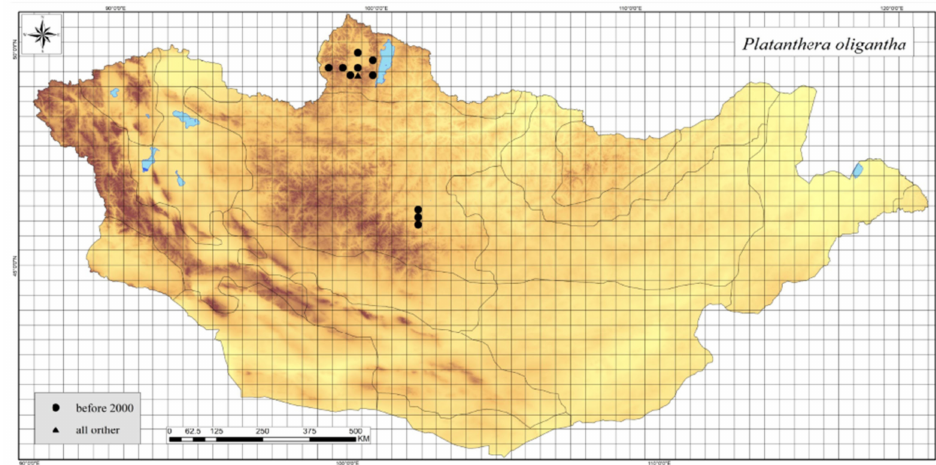
Figure A24. Distribution map of Platanthera oligantha in Mongolia.